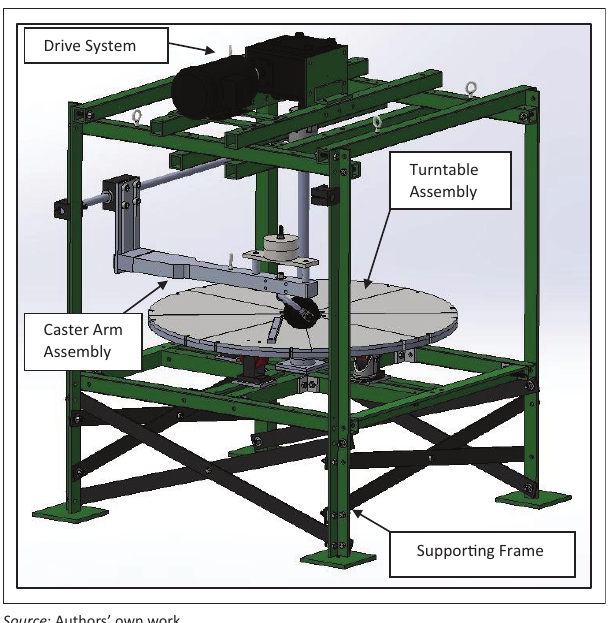
FIGURE 8: Final caster test equipment drawing for fabrication (includes only one of four possible caster support